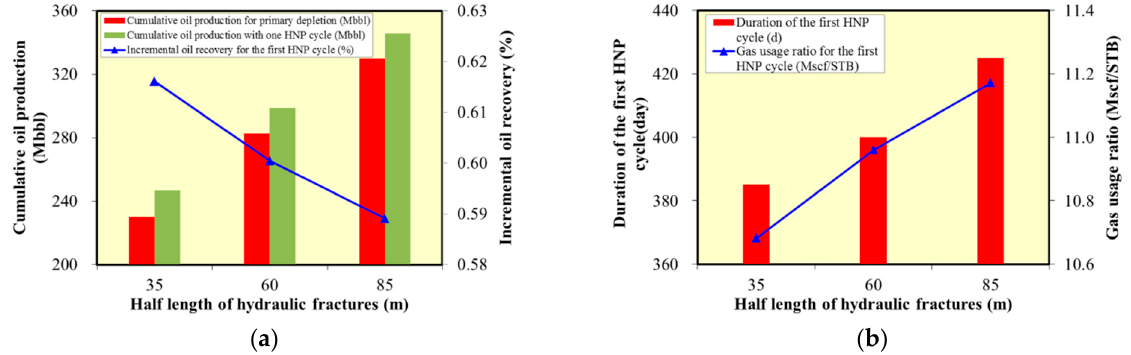
Figure 18. The correlation between half-length of hydraulic fractures and huff-n-puff results: ( a ) Cumulative oil production and incremental oil recovery for different half-length of hydraulic fractures; ( b ) Duration of the first huff-n-puff cycle and gas usage ratio for different half-length of hydraulic fractures.